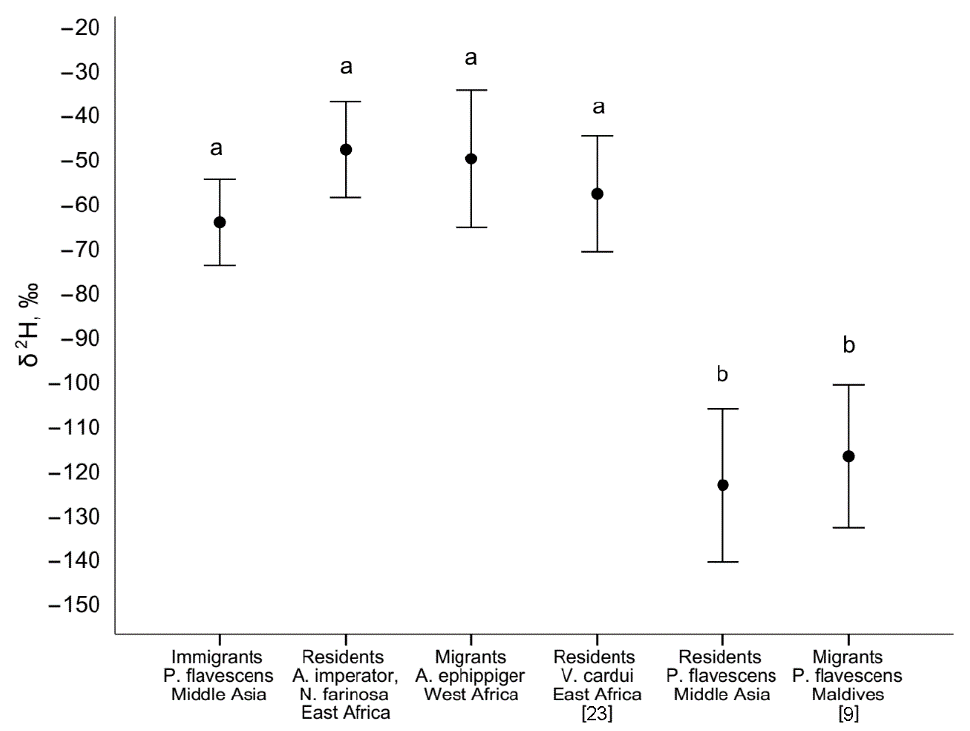
Figure 3. Comparison of the δ 2 H values of immigrants and residents of Pantala flavescens from Middle Asia with resident species of dragonflies ( Anax ephippiger , A. imperator , Nesciothemis farinosa ) and butterflies ( Vanessa cardui ) [23] from Africa, and P. flavescens during autumn migrations through the Maldives [9]. Significant differences between the groups are indicated by different letters (unequal n Tukey’s HSD, p < 0.05; to compare P. flavescens from the Maldives with other groups, a t -test was used, p < 0.05). Mean values and 1 SD are shown.